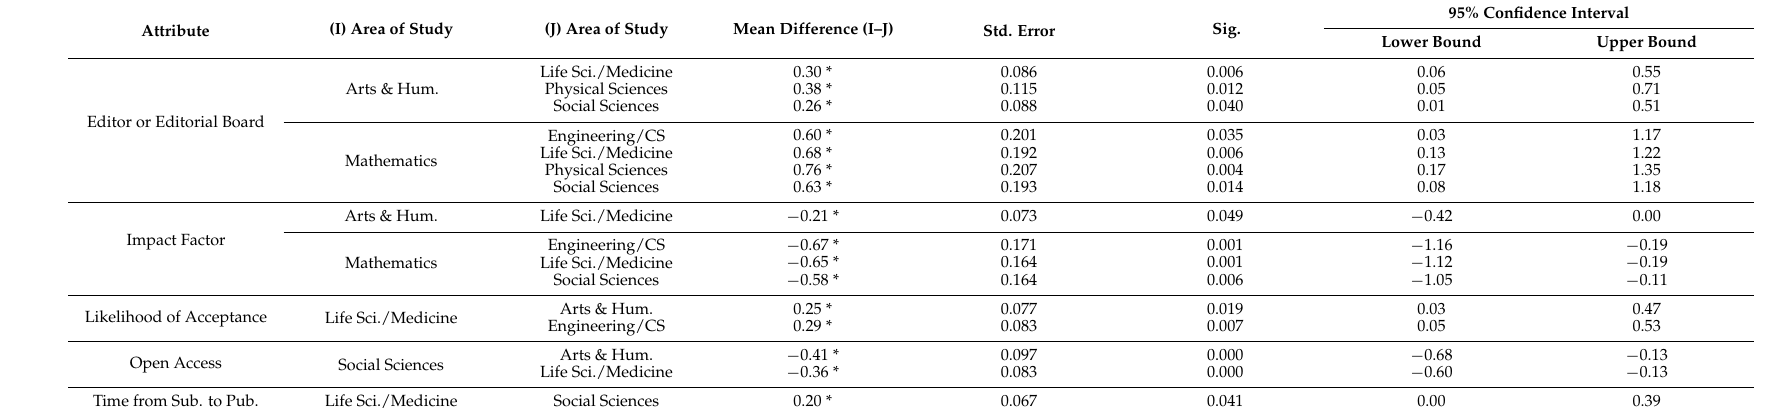
Table 8. Multiple comparisons, subject discipline and journal attributes (Tukey